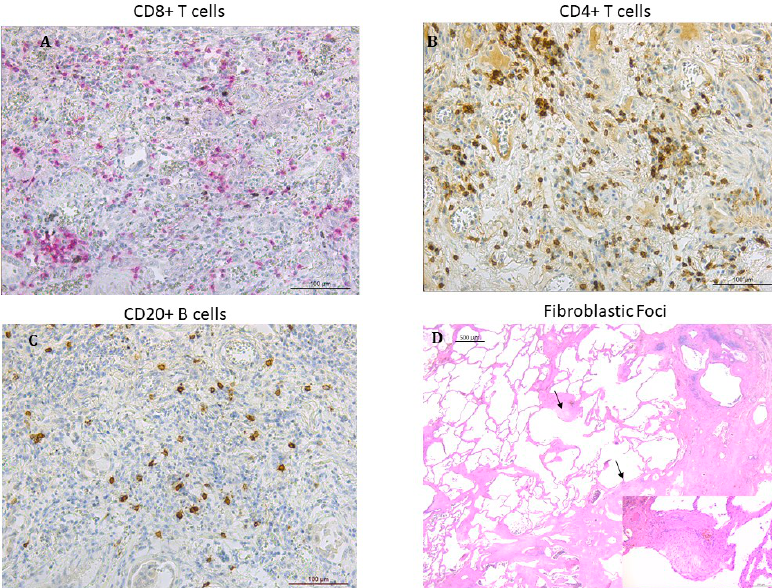
Figure 1. Microphotographs showing lymphocytes infiltrating the lung tissue in patients with IPF: ( A ) CD8 + T lymphocytes stained in red ( B ) CD4 + T lymphocytes stained in brown. ( C ) CD20 + B lymphocytes stained in brown. Immunostaining with monoclonal antibodies anti-human CD8, anti-human CD4 and anti-human CD20. ( D ) fibroblastic foci (arrows) in the transition zone between the normal lung (on the left) and the dense remodeled parenchyma with microhoneycombing (on the right) (hematoxylin and eosin staining). Insert at higher magnification: detail showing a fibroblastic focus composed of spindle cells with overlying hyperplastic pneumocytes (hematoxylin and eosin staining).